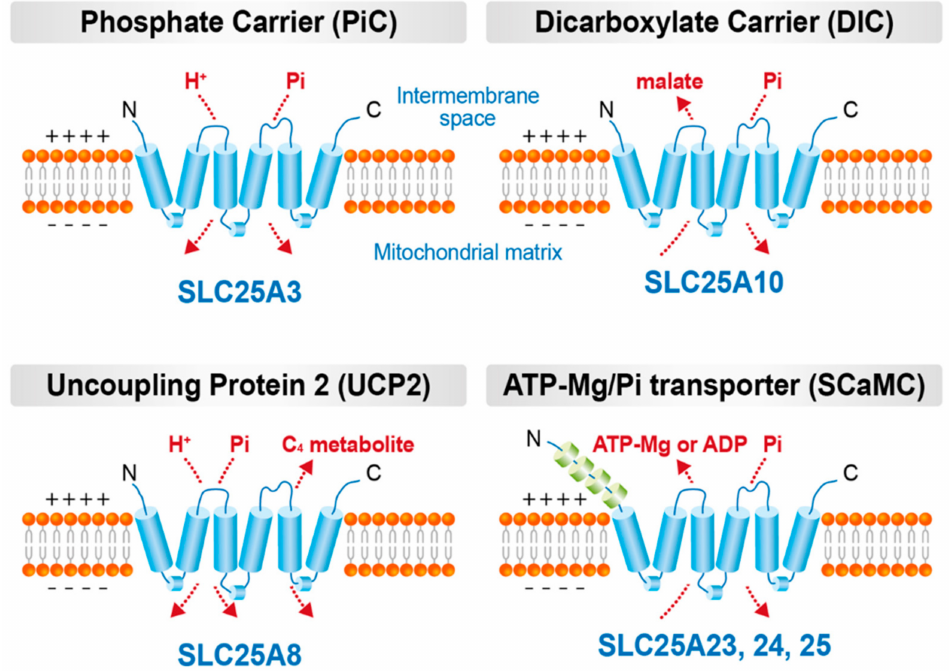
Figure 2. Mitochondrial Pi transporters. Four mitochondrial carriers involved in Pi transport across the inner mitochondrial membrane and their hypothetical transport mechanisms are illustrated. PiC is the main route of mitochondrial Pi uptake driven by pH gradient. DIC exchanges dicarboxylate for Pi or other dicarboxylate, but also transport adenine nucleotides and glutathione. UCP2 performs Pi transport with C 4 metabolites including malate, oxaloacetate, and aspartate. ATP-Mg/Pi transporter has EF hand domains in N-terminal leading to having a Ca 2+ activated